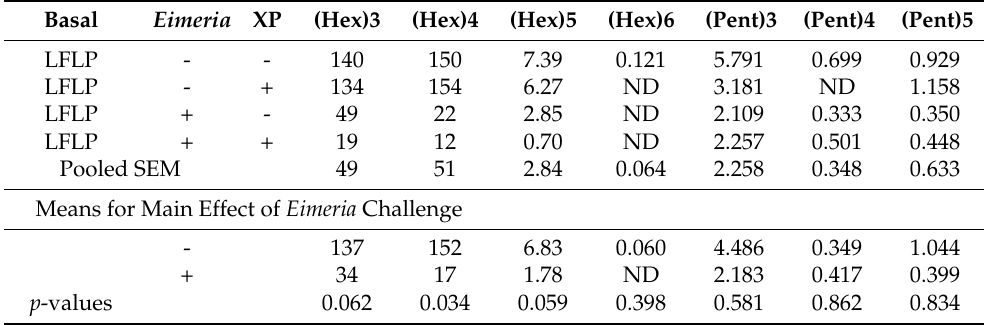
Table 9. Oligosaccharide profile ( µ g/mg) in jejunal digesta of broiler chickens challenged or unchal- lenged with mixed Eimeria spp. in response to feeding diets with low fiber and protein levels with or without enzyme supplementation (Expt.